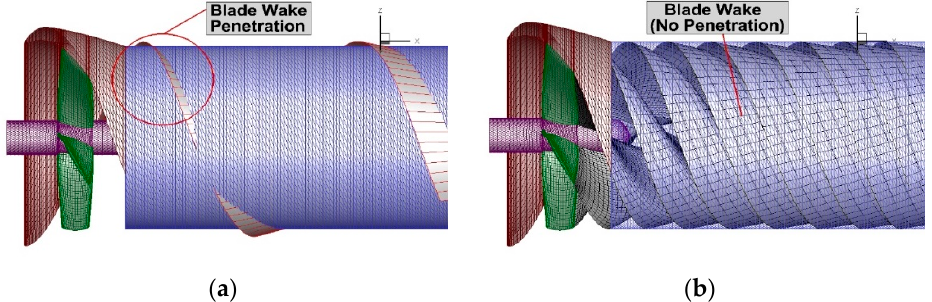
Figure 1. Penetration of the blade wake on duct wake before ( a ) and after ( b ) adjusting the location of the blade wake panels close to the tip. Only half of the duct geometry is